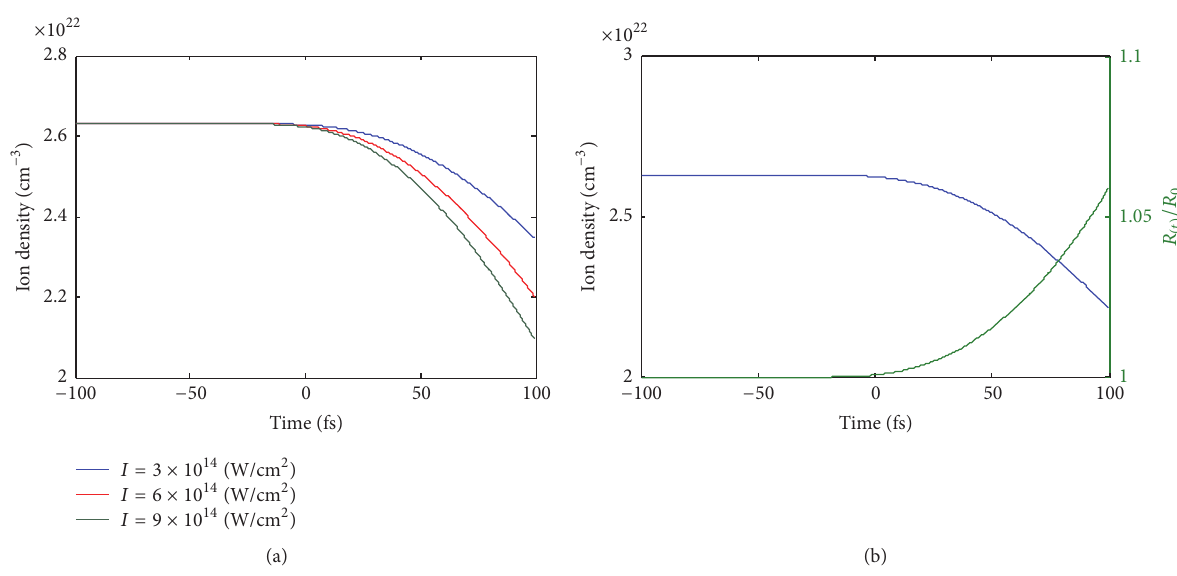
Figure 6: (a) Time evolution of the ion density of Ar cluster at the different laser intensities of 3 × 10 14 Wcm −2 , 6 × 10 14 Wcm −2 , and 9 × 10 14 Wcm −2 . (b) Time evolution of the ion density with the size of cluster.